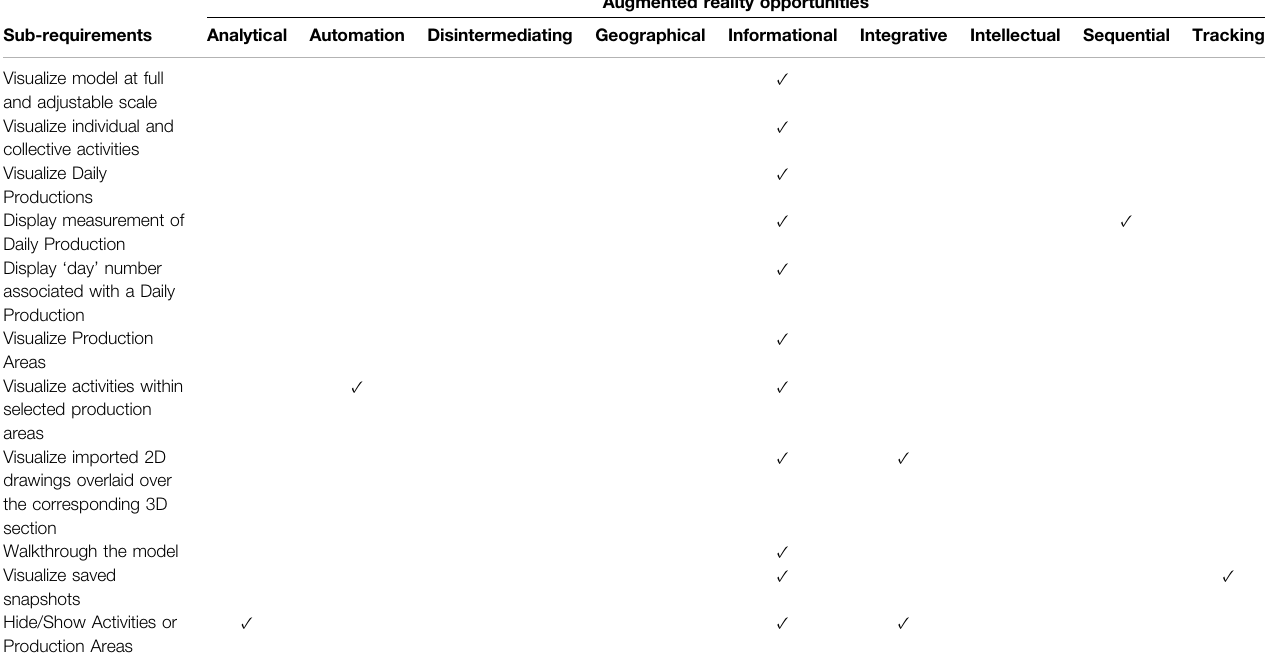
TABLE 4 | Requirement matrix — visualization